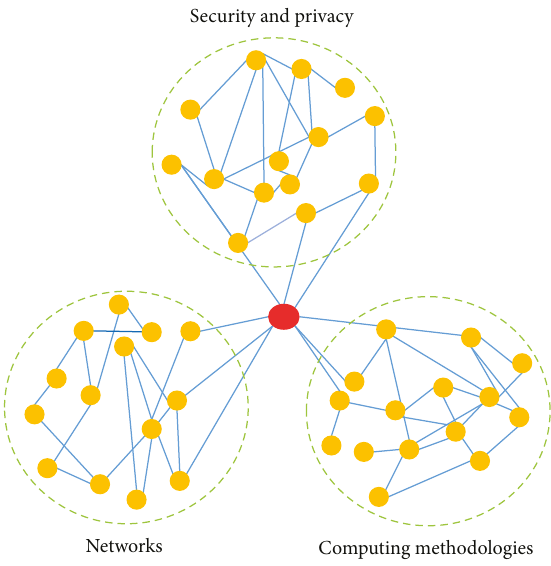
Figure 1: Illustration of structural